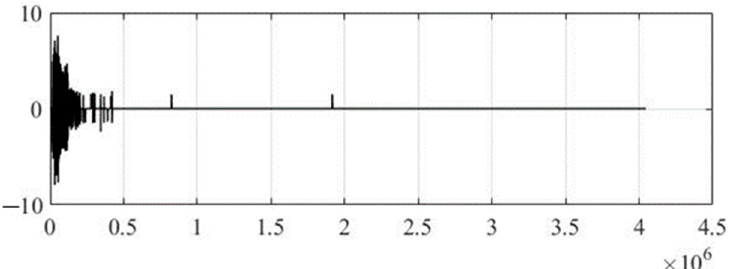
Figure 12. Wavelet coefficients of compressed steganocoded audio signal by 30 times (developed method).